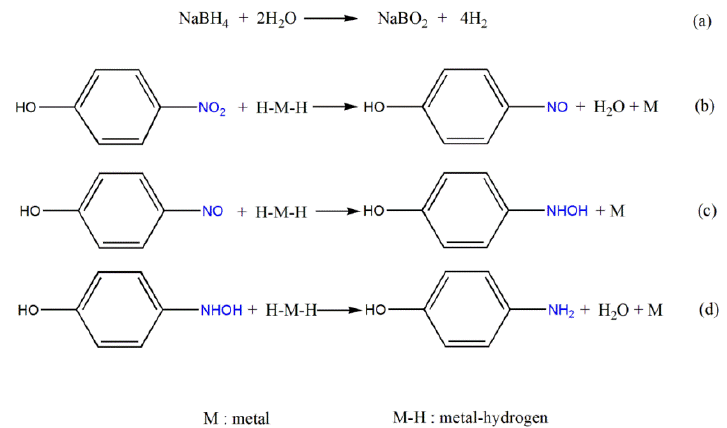
Figure 6. Reaction pathways for the reduction of 4-NP to 4-AP: ( a ) NaBH 4 hydrolyzed to release H 2 ; ( b ) H 2 molecules split to H atoms on the surface of metal NPs and reacted with 4-NP; ( c ) H atoms reacted with the nitrosophenol intermediate to form hydroxylamine; ( d ) hydroxylamine was further reduced to the final product 4-AP. H–M–H represents the split of H 2 molecules on the surface of metal NPs.